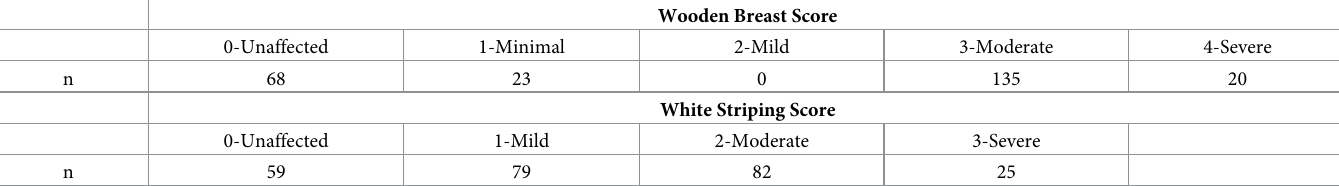
Table 1. Distribution of wooden breast and white striping scores among 7-week-old broiler chickens sampled for metabolomic analysis and confirmed to be geneti- cally male (n = 246 total).